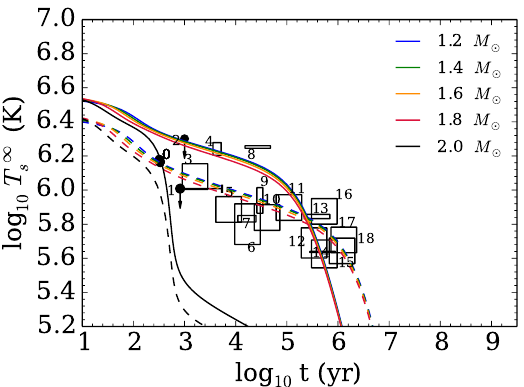
Figure 4. Cooling curves for stars of different mass M / M (cid:12) = 1.2,1.4,1.6,1.8,2.0 for the case of unpaired matter. T ∞ denotes the surface temperature at infinity. The solid curves correspond to the S light-element envelope ( η = 10 − 7 ), while the dashed curves were obtained for the heavy-element envelope. The data points are taken from [59].